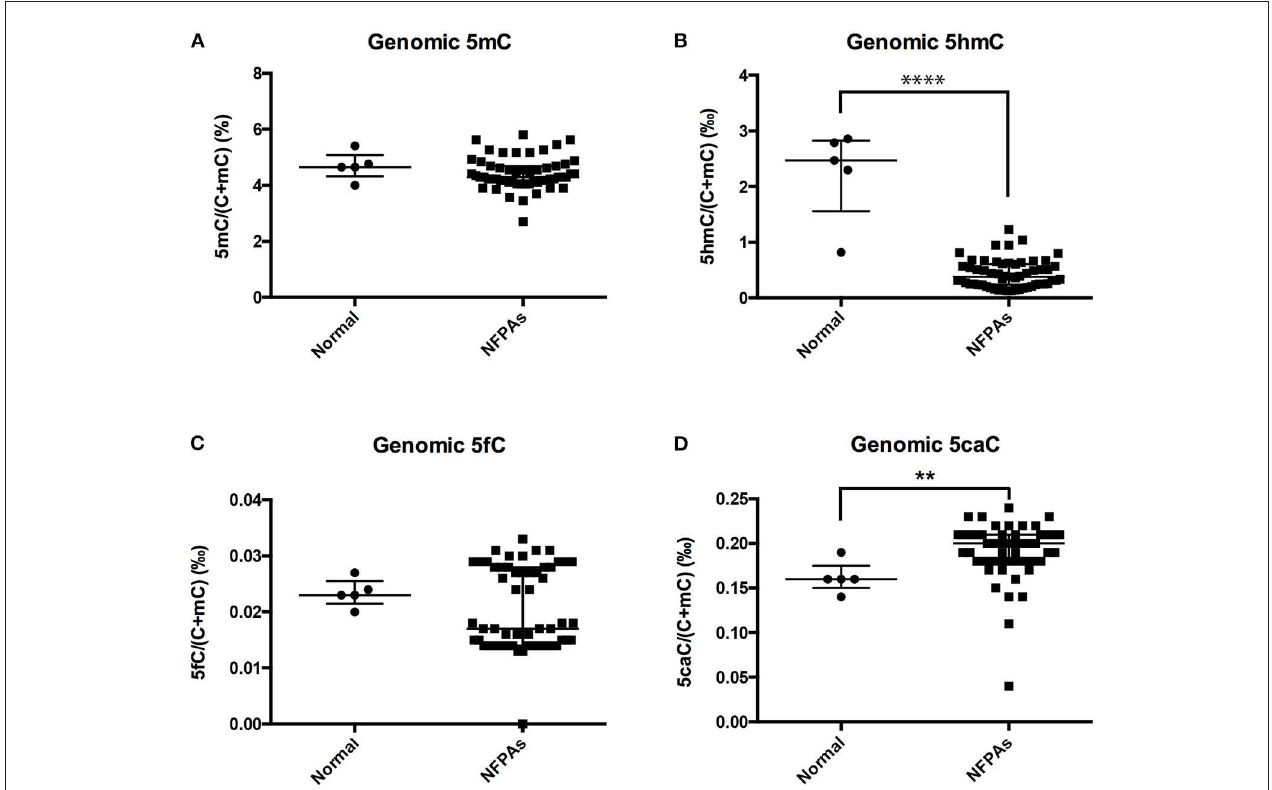
FIGURE 1 | Genomic 5mC, 5hmC, 5fC, and 5caC levels in NFPAs and normal pituitary glands. (A) There was no significant difference in genomic 5mC levels between NFPAs and normal pituitary glands. (B) Genomic 5hmC levels were significantly decreased in NFPAs compared with those in normal pituitary glands. (C) There was no significant difference in genomic 5fC levels between NFPAs and normal pituitary glands. (D) Genomic 5caC levels were significantly increased in NFPAs compared with those in normal pituitary glands. ** P < 0.01; **** P < 0.0001